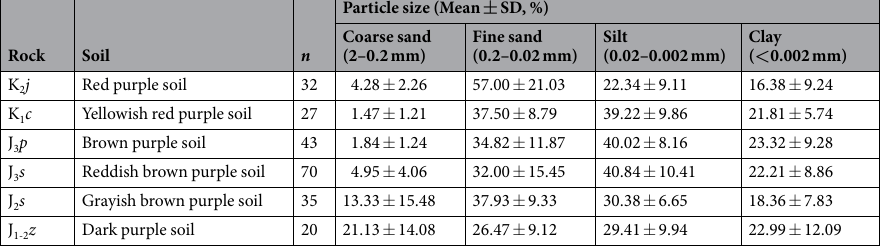
Table 5. The particle size distribution of the purple soils from various purple rocks.